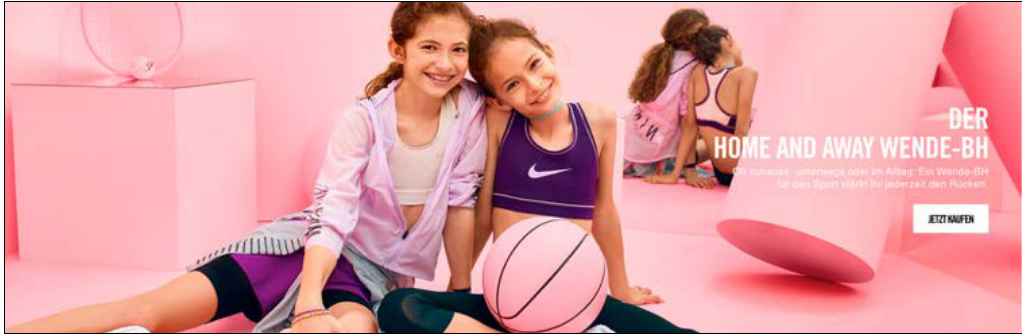
Figure 4 (opposite page): Structurally, alleged women’s interests and creative activities are taken up as household tasks (furnishing rooms, dressing), communication (finding friends) and interests (fashion, shopping). The opposite strategy also exists, which does not explicitly mention gender but it becomes apparent which gender is clearly addressed through the imagery. Source: http://ikea.co/de. Accessed: November 24,